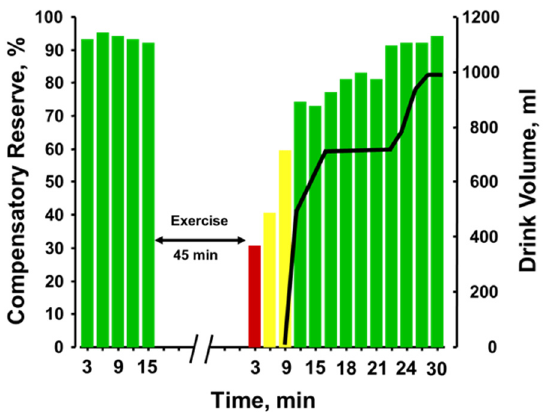
Figure 9. Compensatory reserve measures before and after 45 min of running exercise in the heat and resting recovery (10 min) and then fluid replacement (black line). Bar colors: green, compensatory reserve >60%; yellow, compensatory reserve ≤ 60% and >30%; red, compensatory reserve ≤ 30%. BL, baseline; W, watts. Image modified from [52].